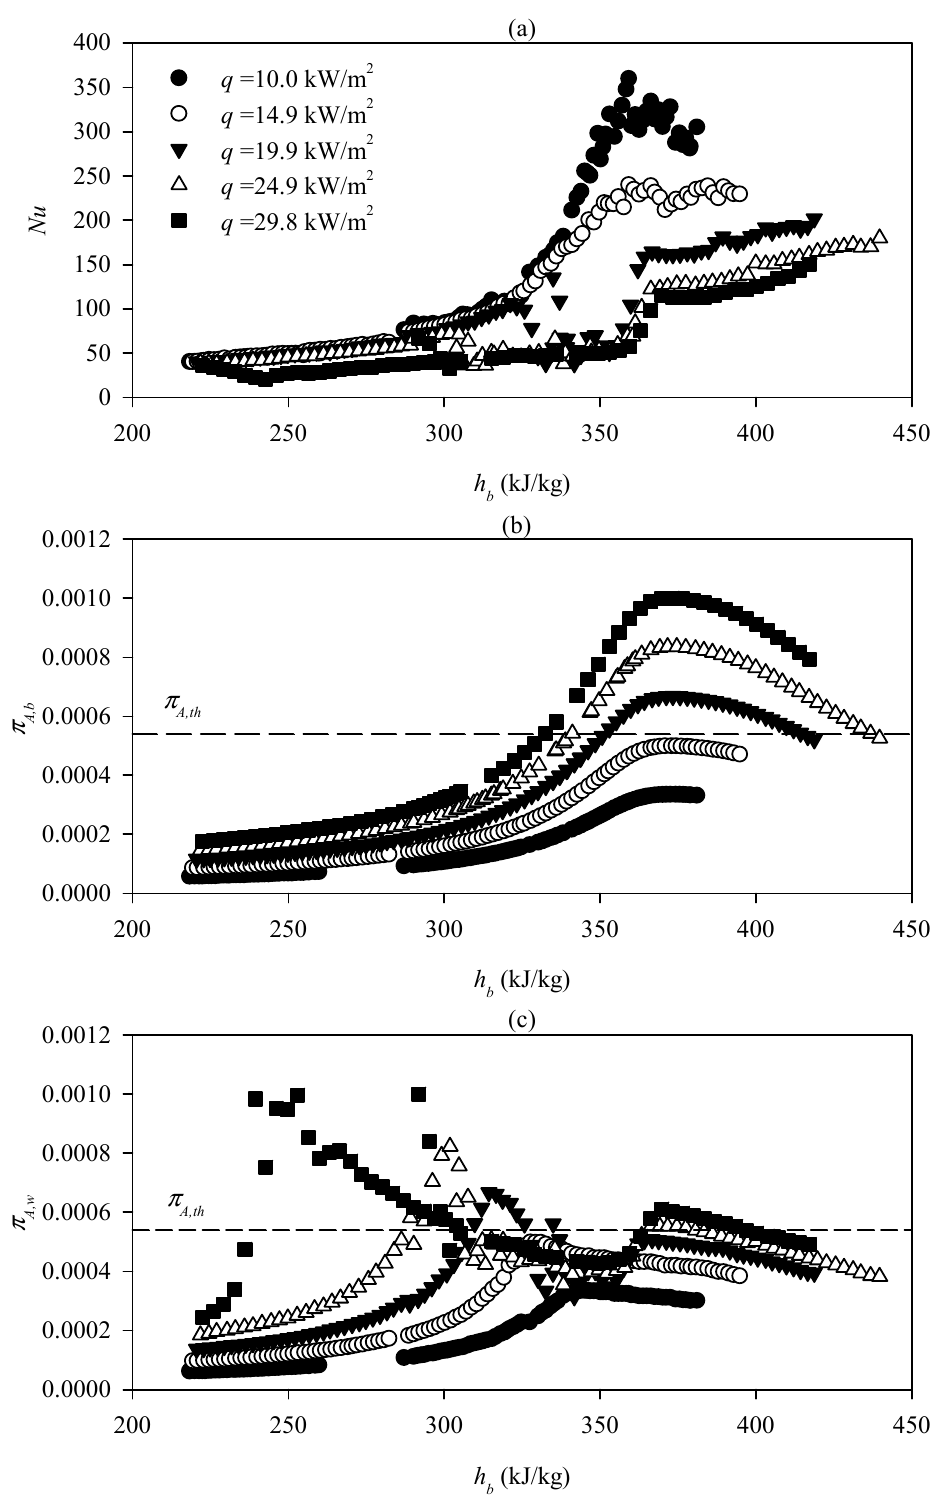
Figure 6. ( a ) Nusselt number, ( b ) π A at both bulk and ( c ) wall condition vs. enthalpy for R-22 at mass flux of 400 kg/ m 2 ∙ s subject to heat fluxes [5].